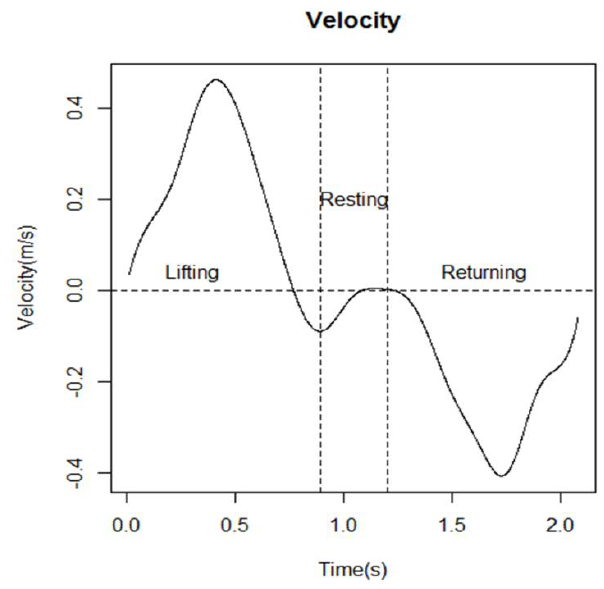
Figure 3. A sample of tangential velocity of an elbow joint during touching-the-contralateral-shoulder task of 20s age group.